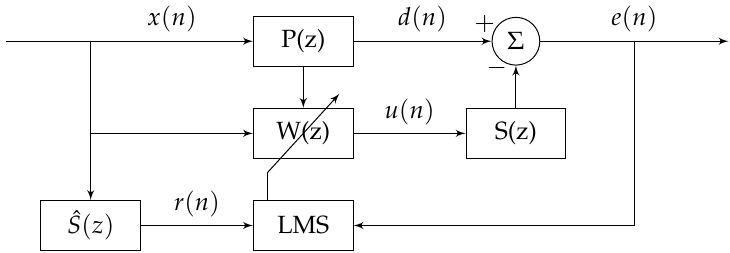
Figure 13. The scheme of the FxLMS algorithm [2].